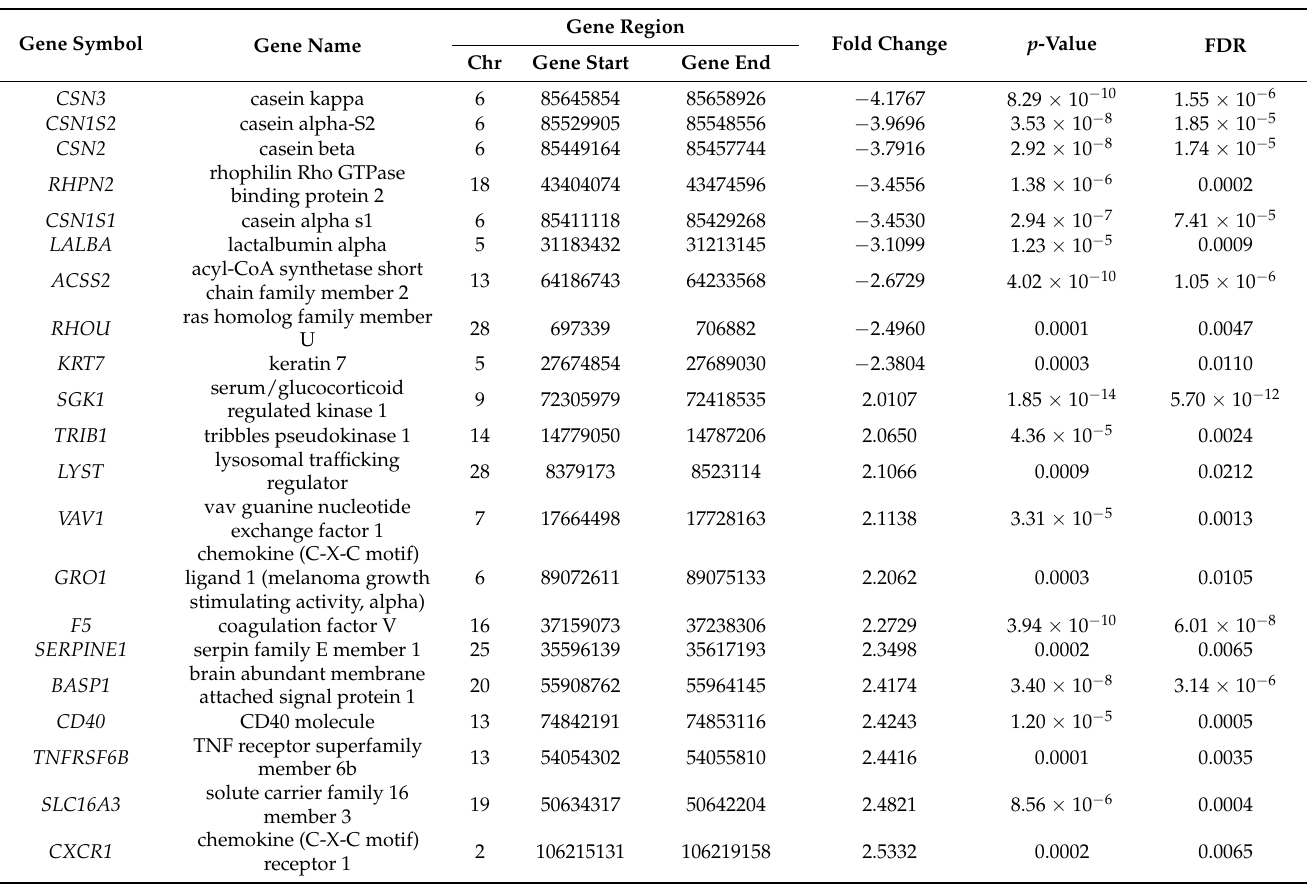
Figure 2. Venn diagram of significant genes among the three types of dataset, including microarray, RNA-Seq, and GWAS data related to mastitis in dairy cattle. Table 3. Summary list of 33 common genes (main genes) in the integrated studies of gene expression and GWAS associated with mastitis in dairy cattle *.